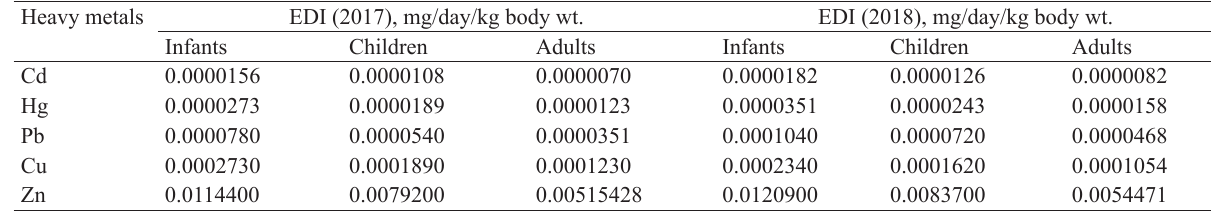
Table 1 Estimated daily intakes (EDI) of elements in the edible tissues of Merlangius merlangus L. from the southern Black Sea Heavy metals